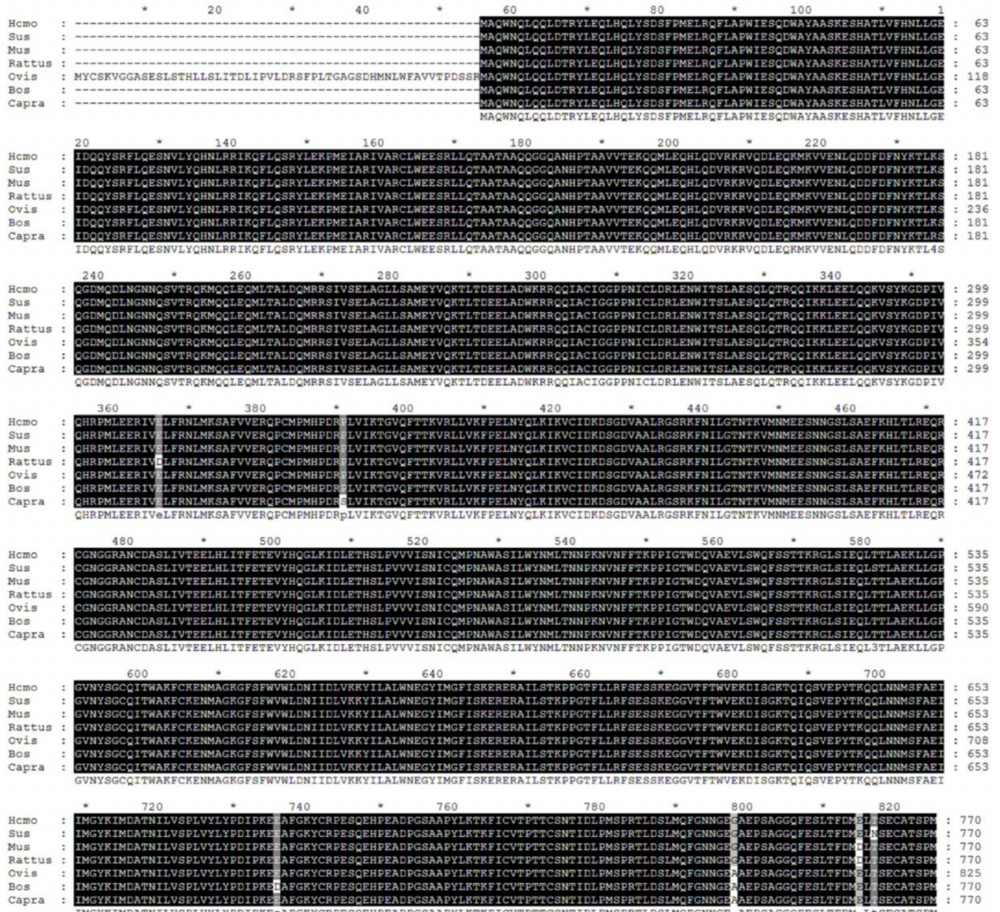
Figure 1. Multiple sequence alignment of STAT3 protein across seven species. The degree of similarity is delineated using different background shading, with black being 100%; grey with black text, 80%; grey with white text, 60%; and white, not conserved.